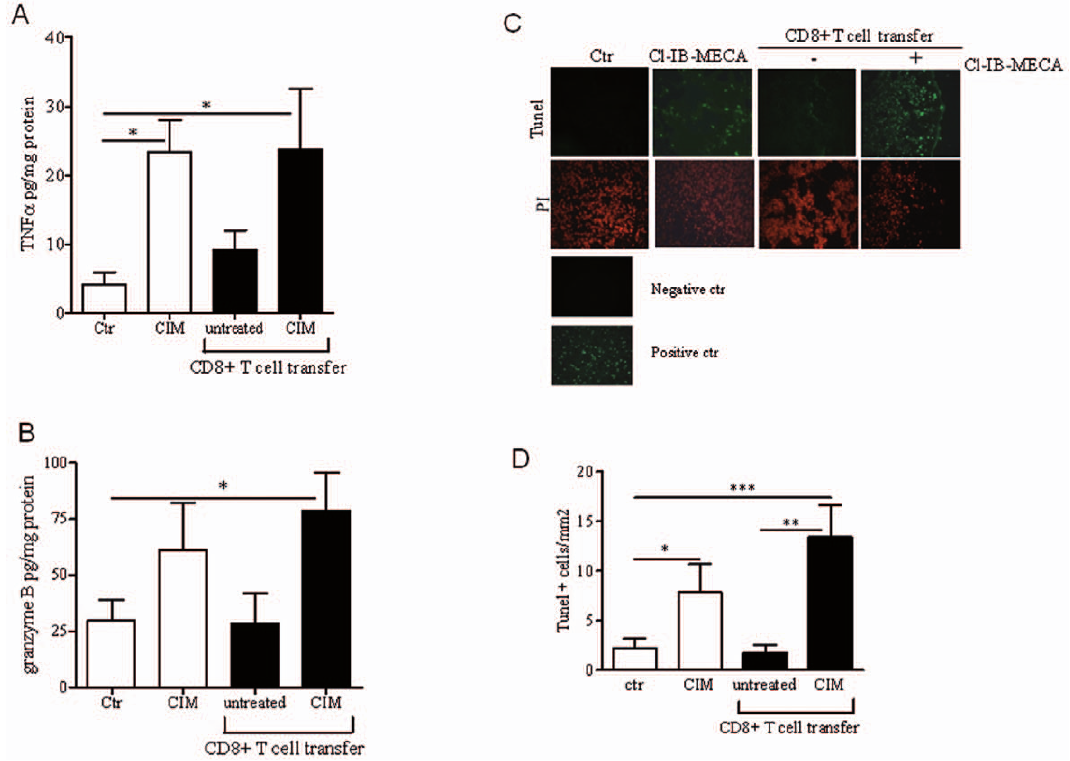
Figure 2. Invivo effectiveness of CD8 + T cell transfer after Cl-IB-MECA treatment is associated with increased apoptosis rate, granzyme B and TNF- a release into melanoma lesions. A ) and B ) TNF- a and granzyme B levels, respectively, detected into tissue homogenates from mice adoptively transferred with Cl-IB-MECA-stimulated CD8 + T cells or Cl-IB-MECA-treated mice. C ) Representative pictures of melanoma cryosections Tunel stained (FITC) and stained with PI (red). Positive and negative controls are also provided. D ) Quantitative analysis of Tunel + cells detected in melanoma sections. Results are expressed as mean 6 SEM (n=5/group). Data are from two independent experiments and represent mean 6 SEM, n=6 in each experiment. Statistical difference was determined by one way ANOVA. *p , 0.05, **p , 0.01, ***p ,